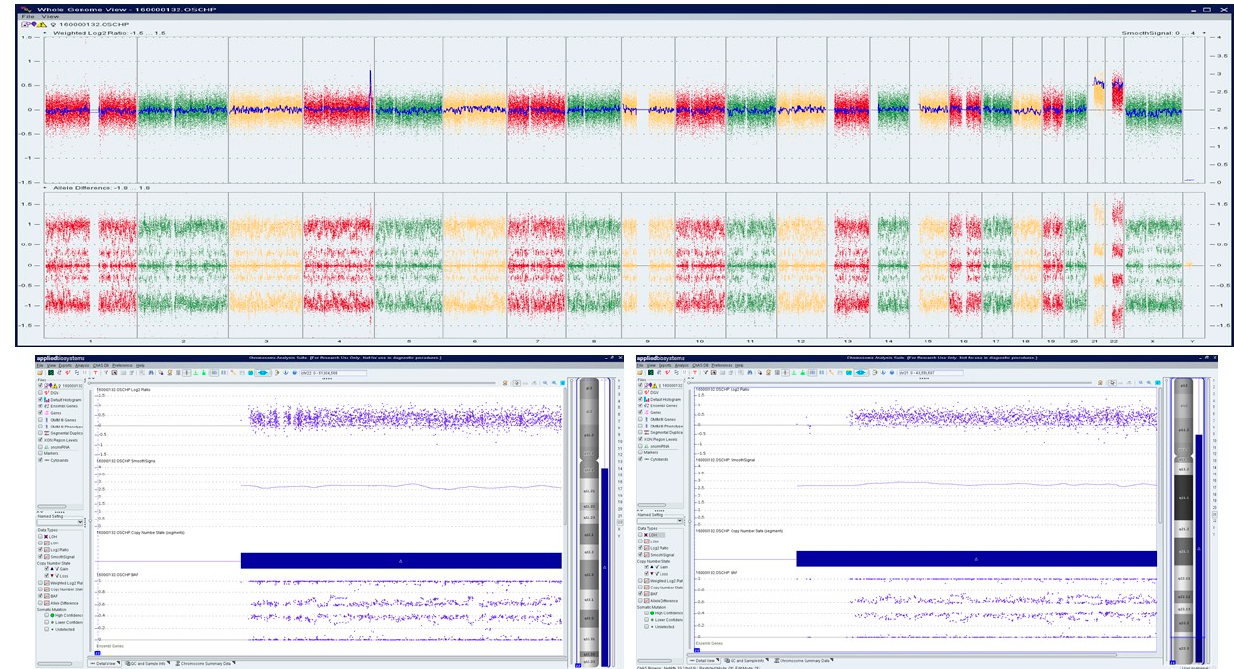
Figure 5. OncoScan analysis identifying double mosaic trisomies involving chromosomes 21 and 22 (ascertained as ~70% mosaic gain), and a copy number gain of Chr 4q, a variant of uncertain significance: Upper panel shows whole-genome view, lower panel shows log2ratio, smooth signal, and B-Allele Frequency (BAF) of chr 21, c) log2ratio, smooth signal, and BAF of chr 22. A Caucasian female (>30 years) with a history of over three miscarriages and multiple failed attempts at karyotyping had a miscarriage in the second trimester of her subsequent pregnancy. The patient had a medical history of hypothyroidism, recurrent pregnancy loss, and was reported to harbor a compound heterozygous MTHFR gene mutation. Cytoge- netic/karyotyping could not be performed on this specimen, as no metaphase cells were present. On analyzing the FFPE POC tissue with macrodissection, a 22.6 Mb copy gain of Chr 2q34q37.2 and a 6.4 Mb copy loss of Chr 2q37.2q37.3 was identified, indicating